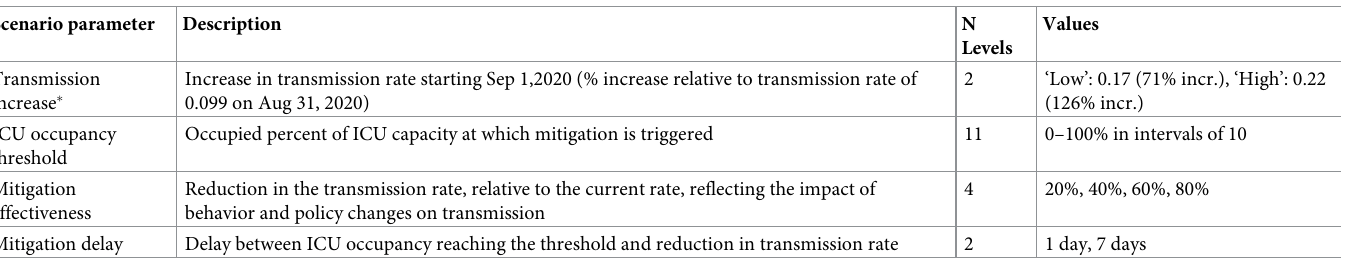
Table 1. Overview of simulated